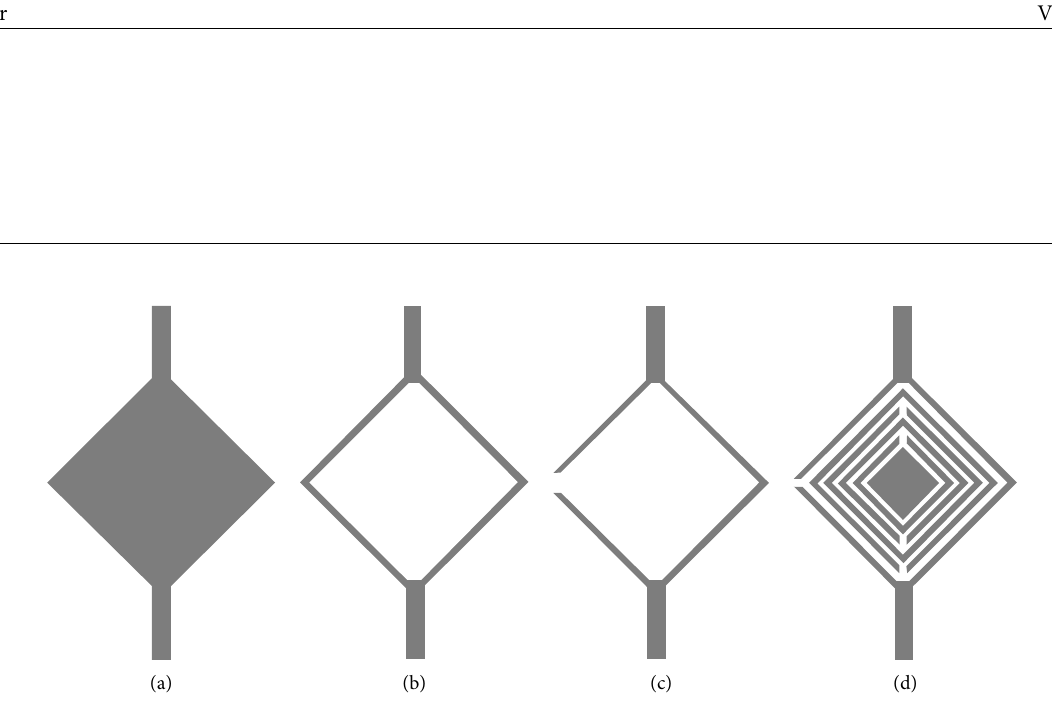
Figure 2: Design procedure of the proposed filter: (a) Step 1, (b) Step 2, (c) Step 3, and (d) Step